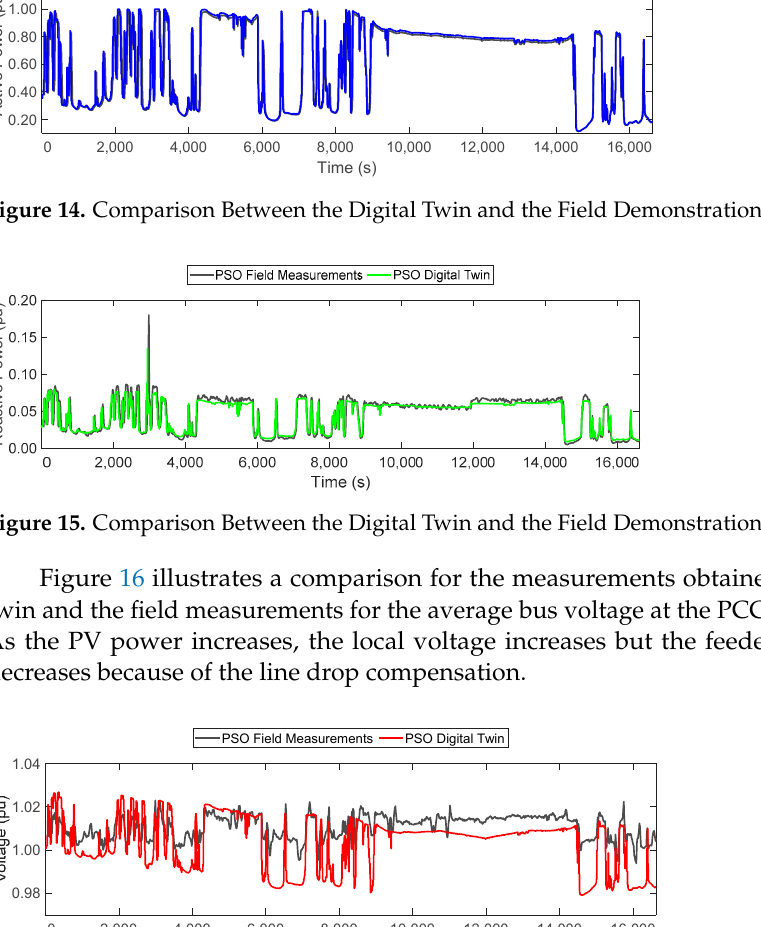
Figure 16. Comparison Between the Digital Twin and the Field Demonstration Voltage at PCC.